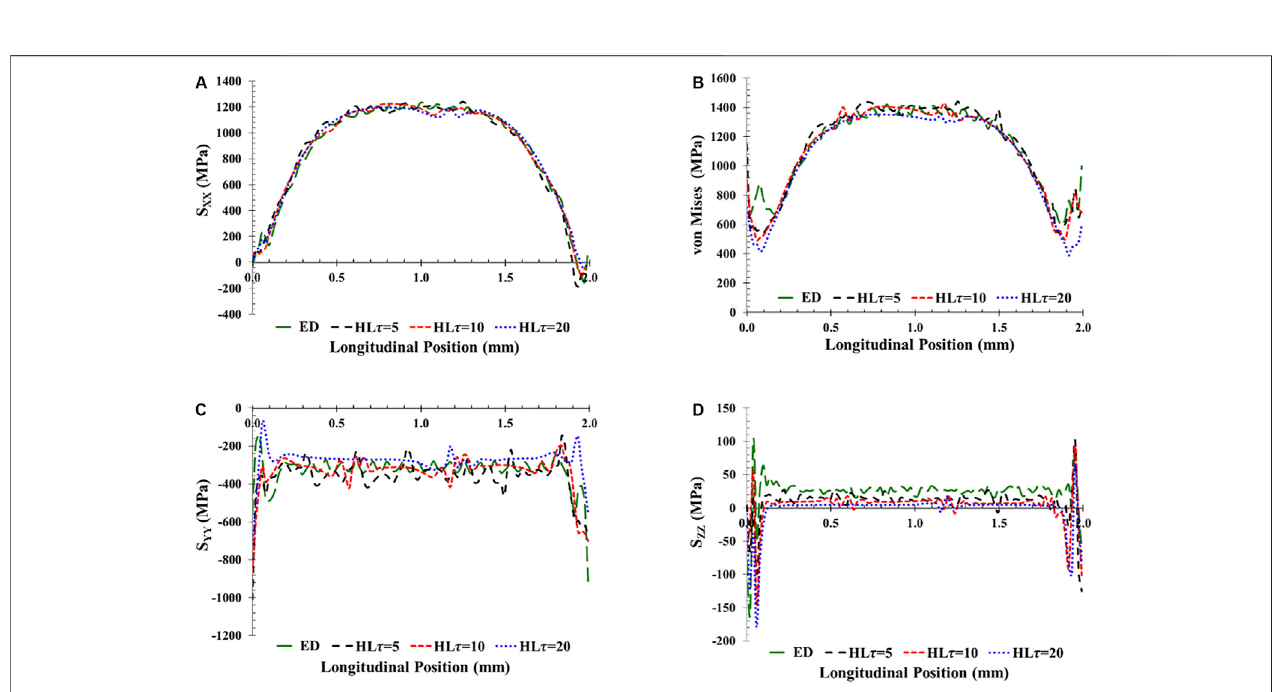
FIGURE 7 | Single-track residual stress distributions along line 1 in Figure 2 for ED and HL models. (A) von Mises (B) S XX (C) S YY (D) S ZZ stresses.